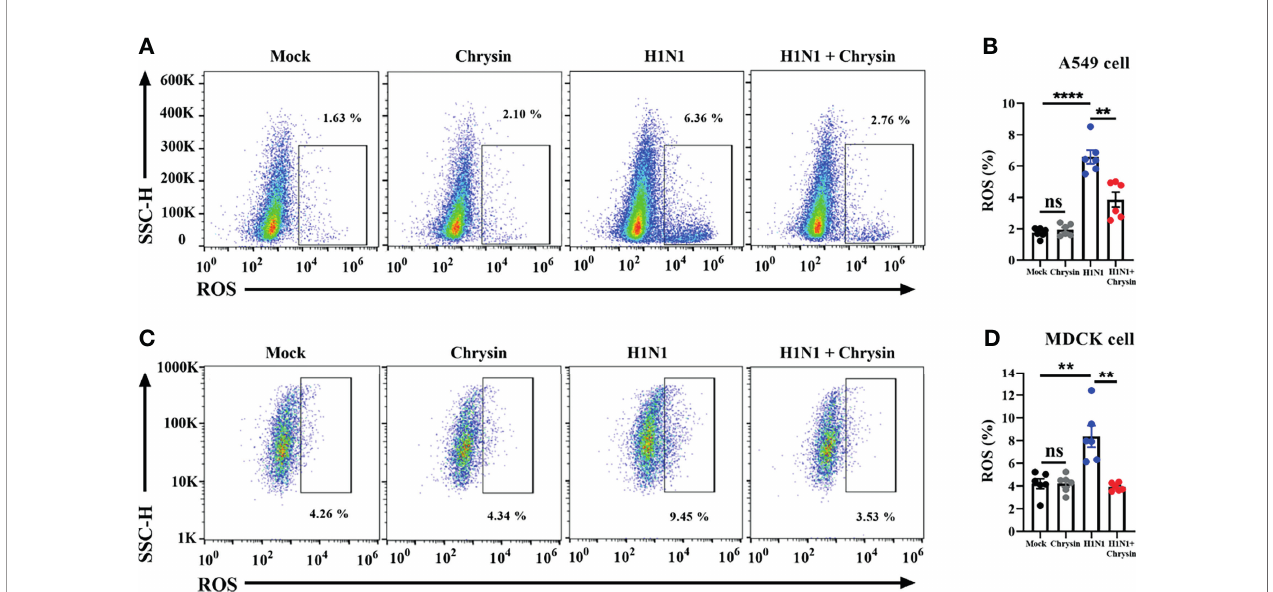
FIGURE 7 | Chrysin abrogates H1N1 in fl uenza virus-induced ROS production. A549 cells or MDCK cells were infected for 2 hours with a MOI of 0.5 A/PR/8/34 (H1N1) virus and 8 m M chrysin, then the supernatant was withdrawn and replaced with medium containing 8 m M chrysin for a total of 10 hours of treatment. A549 cells (A, B) and MDCK cells (C, D) were stained by DCFH-DA for fl ow cytometry analysis. Data are presented as mean ± SEM of three independent experiments with similar results. **P < 0.01, ****P < 0.0001 , by unpaired two-tailed Student ’ s t-test. ns, no signi fi cant difference.